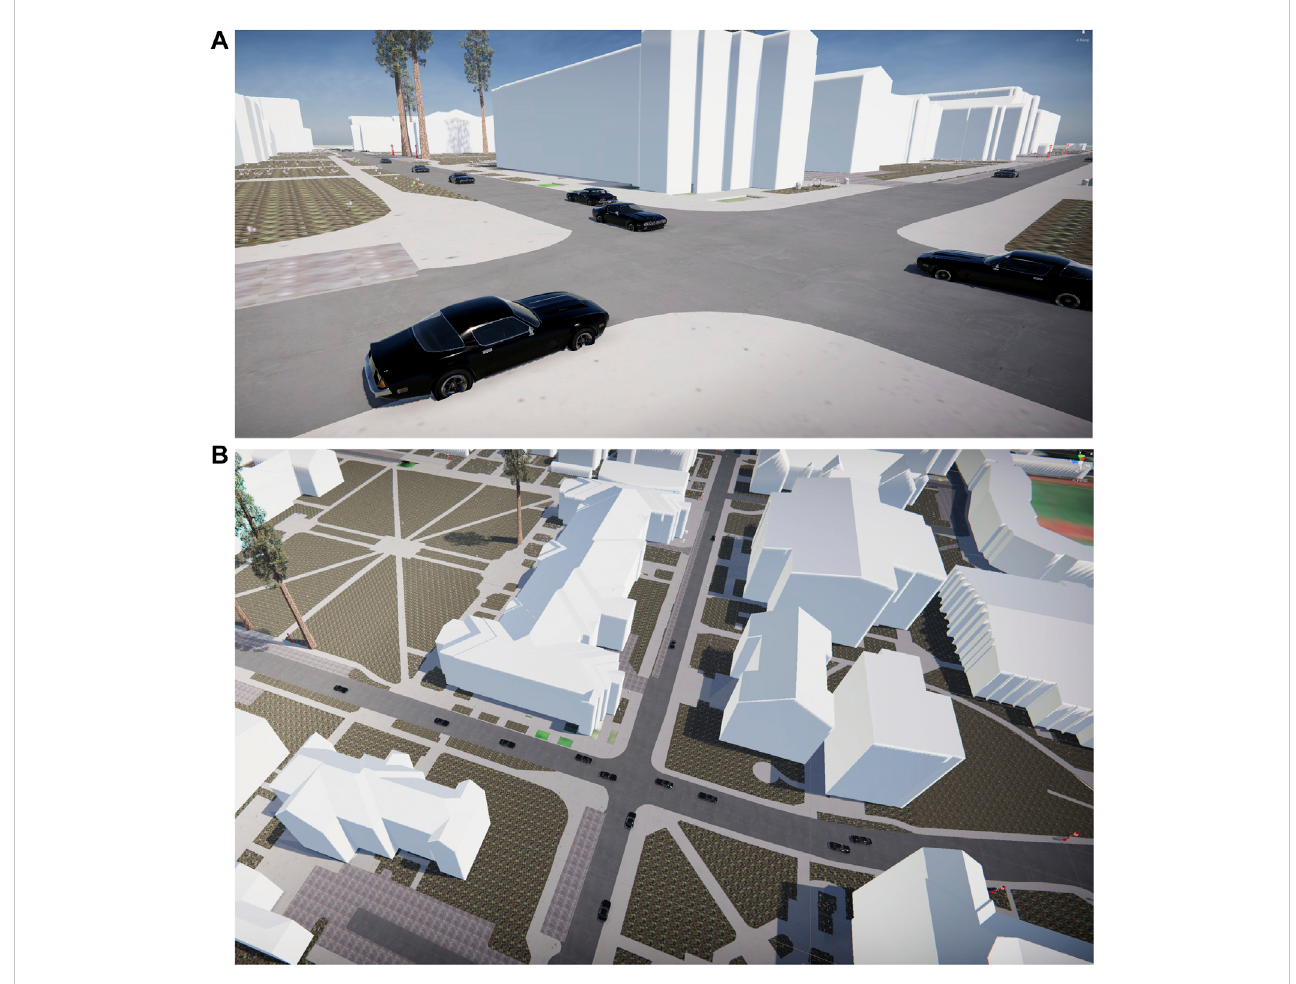
FIGURE 6 A 3D model of the Oregon State University Campus is visualized in Unity. The cars visible in the visualization are simulated using SUMO. (A,B): Different Views of the visualization running inside